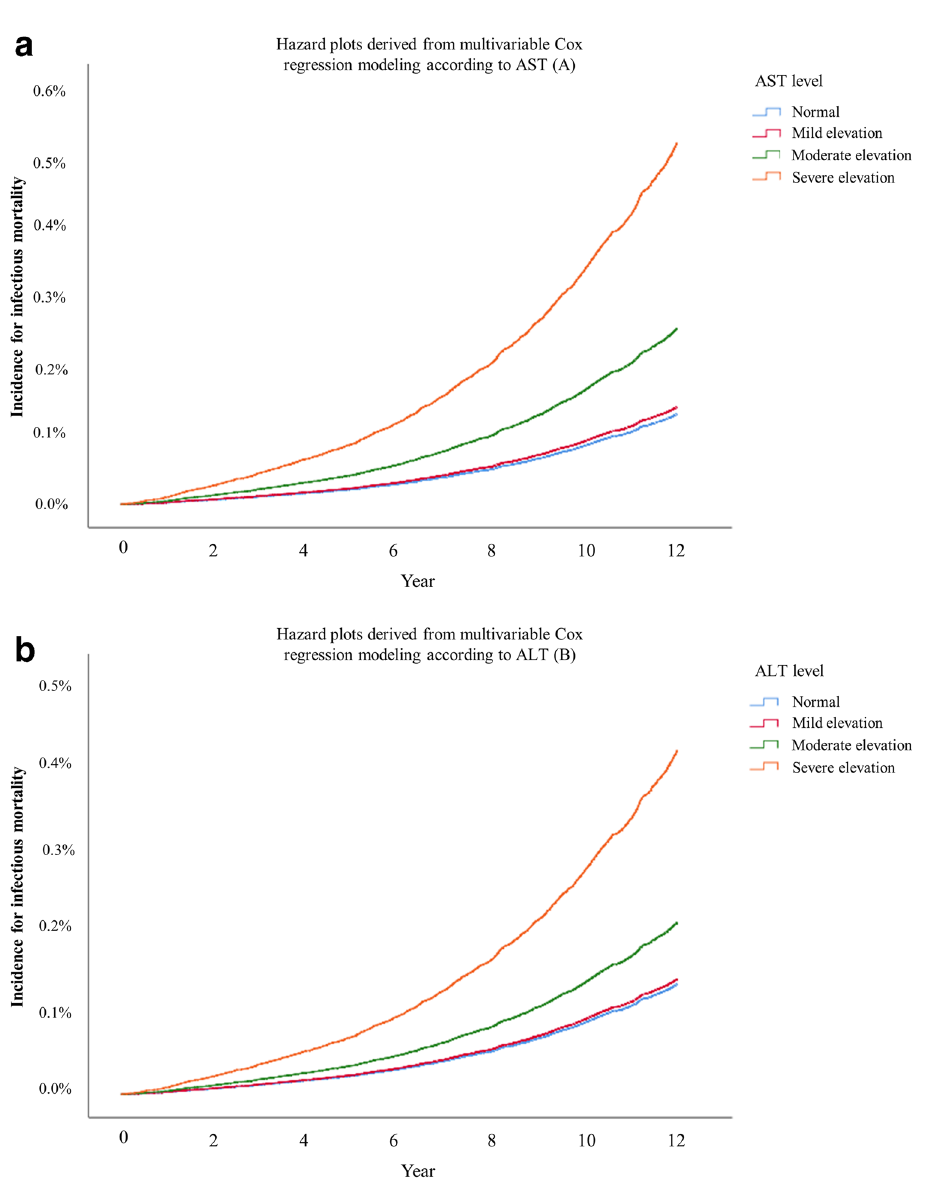
Figure 2. Hazard plots derived from multivariable Cox regression modeling according to AST ( a ), ALT ( b ), and γ-GTP ( c ) level